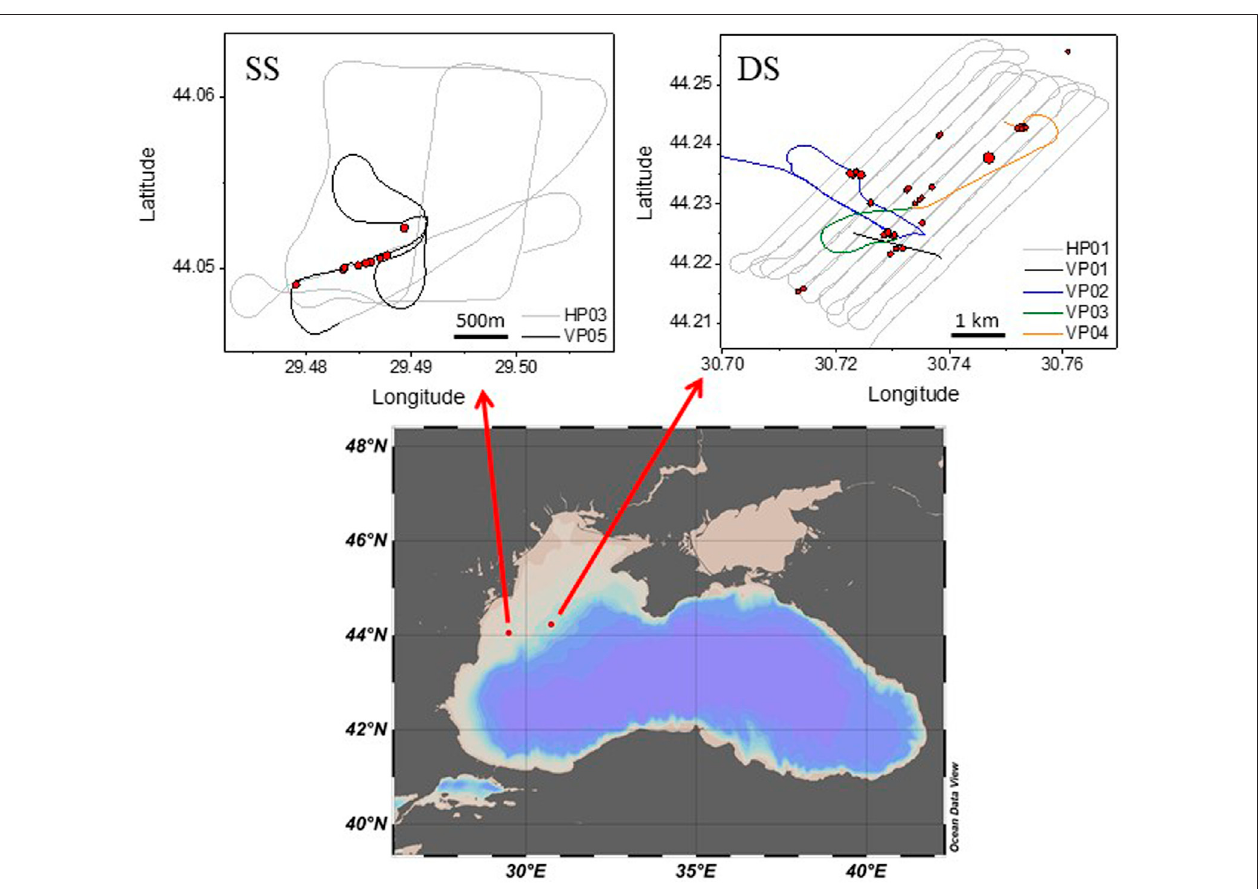
FIGURE 1 | Maps of the survey areas. At the bottom a large map of the Black Sea, and at the top two maps of the shallower site (SS, left) and deeper site (DS, right) with the trajectories of the vessel for the pro fi les of interest for this work. VP are vertical and HP are horizontal near-surface pro fi les in the water. During the vertical pro fi les the position of the vessel was drifting due to water current. Red dots are the locations of fl ares identi fi ed during the survey by the echosounder, with the size proportional to the strength estimated from the acoustic signature.